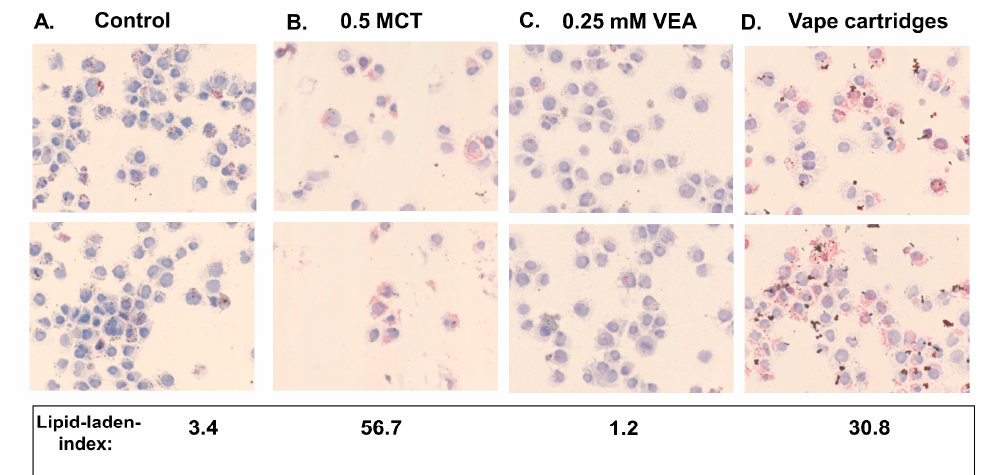
Figure 4. Representative images of lipid-laden macrophages formed by MCT, VEA, and CBD / counterfeit cartridge liquid treatments. MM6 cells were seeded in 5% complete media and treated with 0.00005% (0.0003%) six unknown cartridge liquids 6 h later. Twenty-four hours post-treatment, cells were collected and stained with Oil-Red-O ( n = 3). The averaged lipid-laden indices of the representative images were